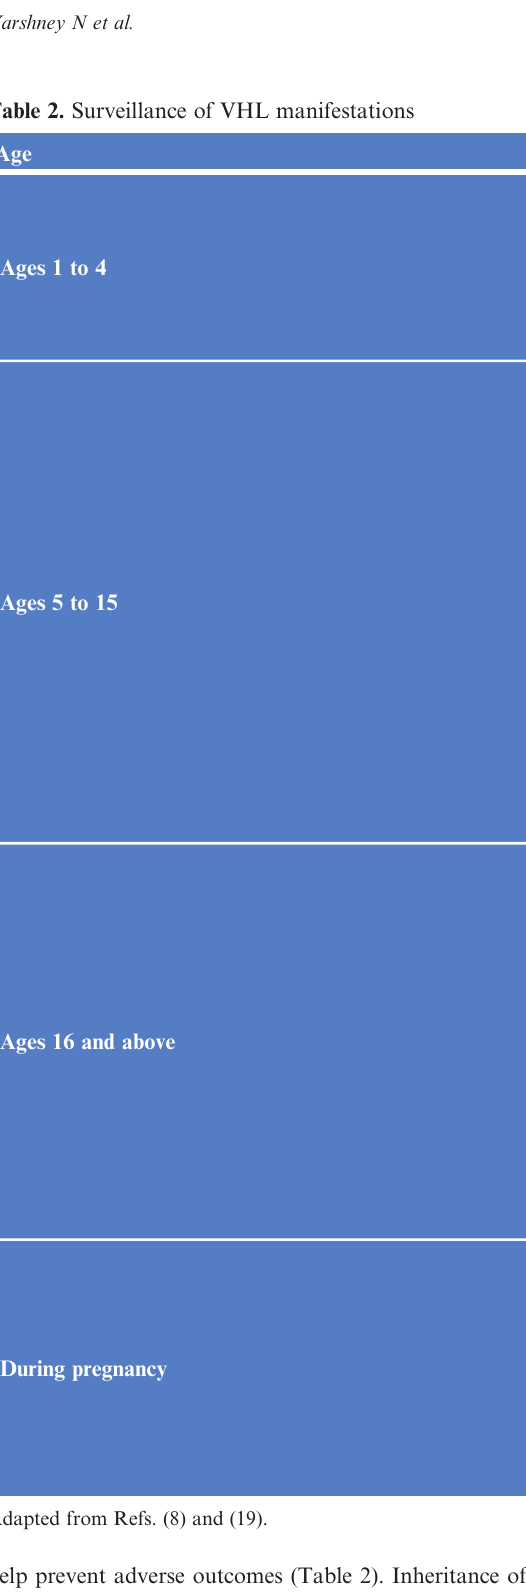
Table 2. Surveillance of VHL manifestations Age